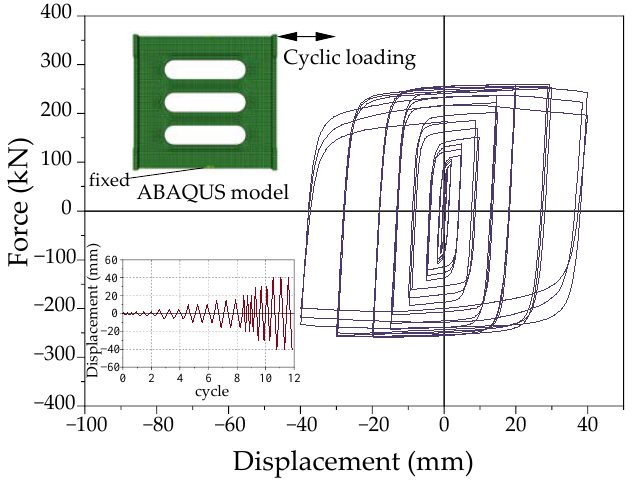
Figure 7. Hysteresis loop of the CSSD numerical model under cyclic loadings.